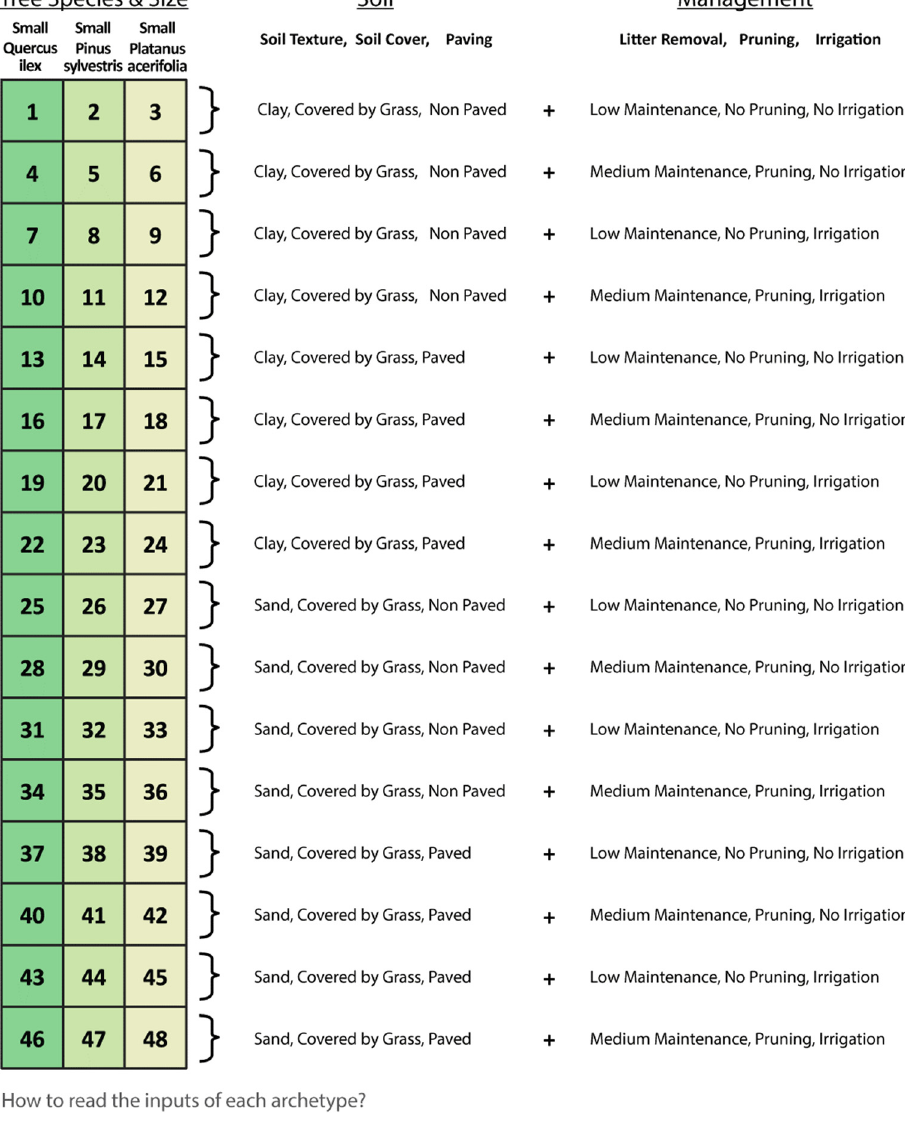
Figure 8. Attributes of 48 illustrative urban forest archetypes modelled for the local conditions of Barajas in the northeast of Madrid (Spain). An example of how to read the attributes of each archetype, and which combination of attributes corresponds to each archetype number, is provided at the bottom.